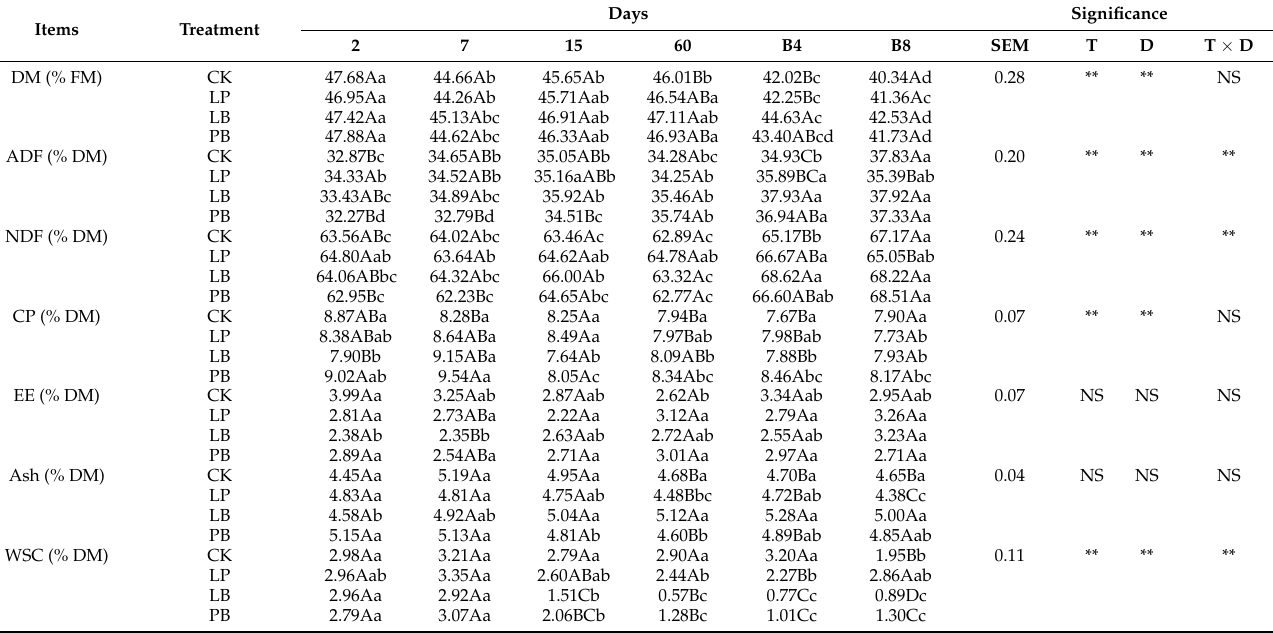
Table 2. Effects of additives and days of anaerobic fermentation and aerobic exposure on the chemical composition of native grass